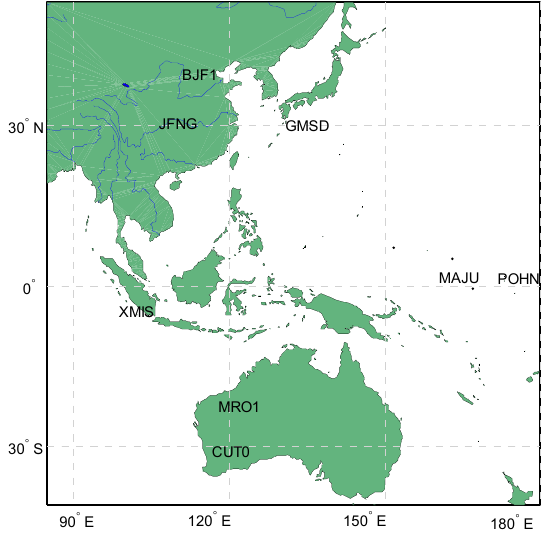
Figure 3. The distribution of the eight experimental stations. Table 1. The unknown estimations in Equation (3).